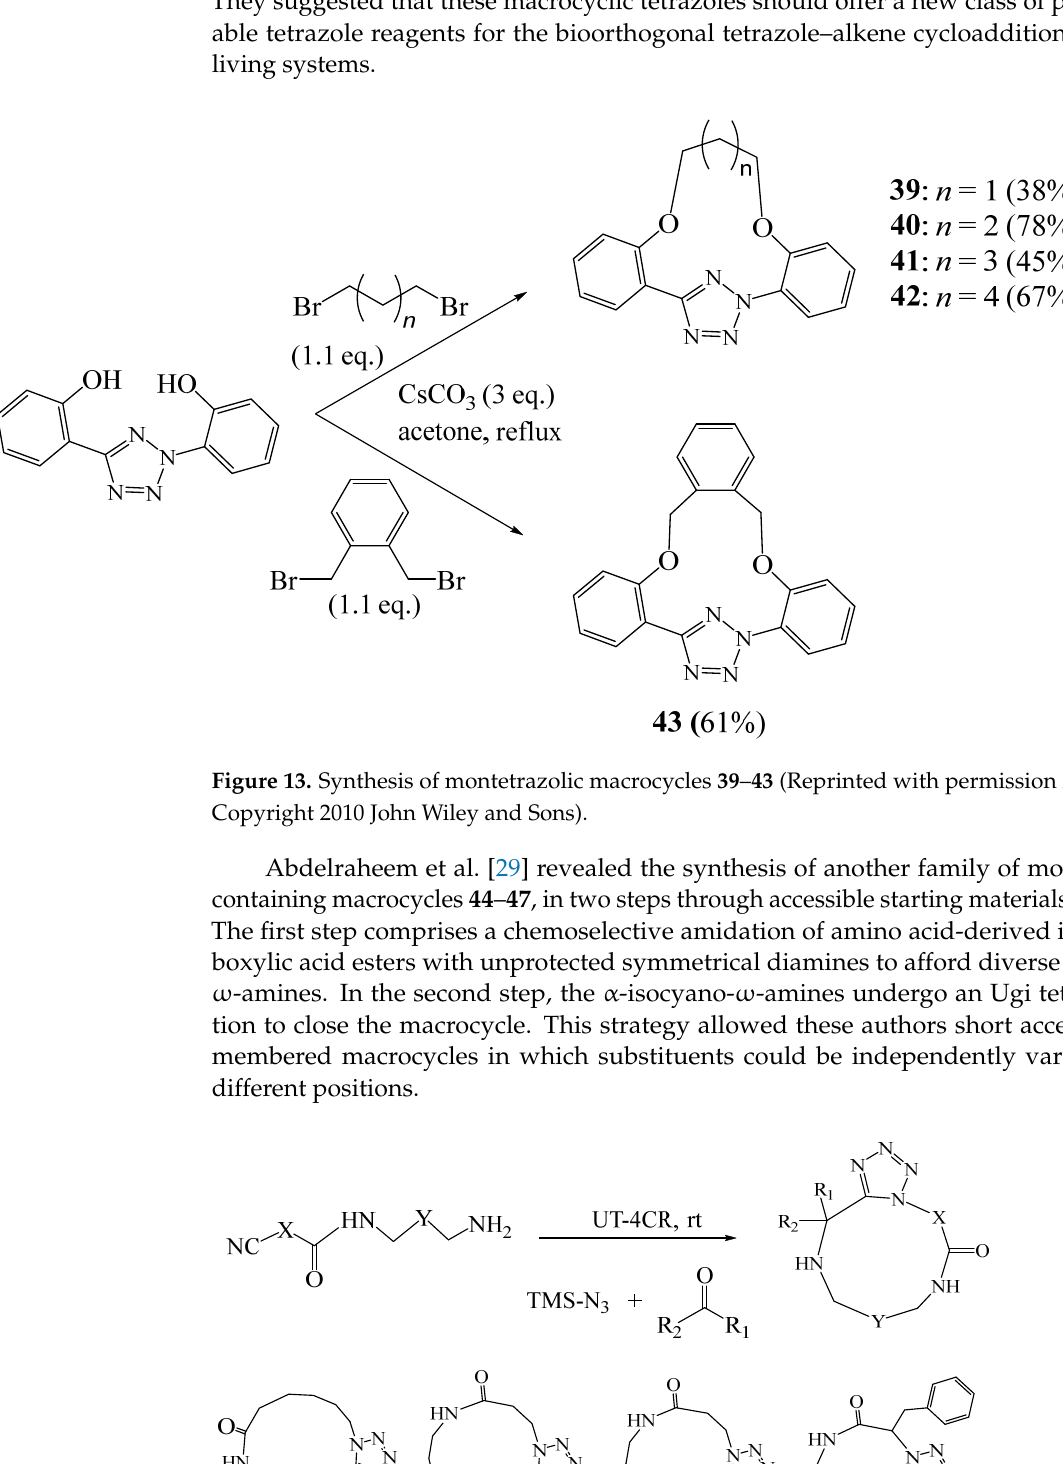
Figure 12. Synthesis of tetra-imidazolic macrocycle salt 38. (Reprinted with permission from ref. [27]. Copyright 2005 Royal Society of Chemistry).